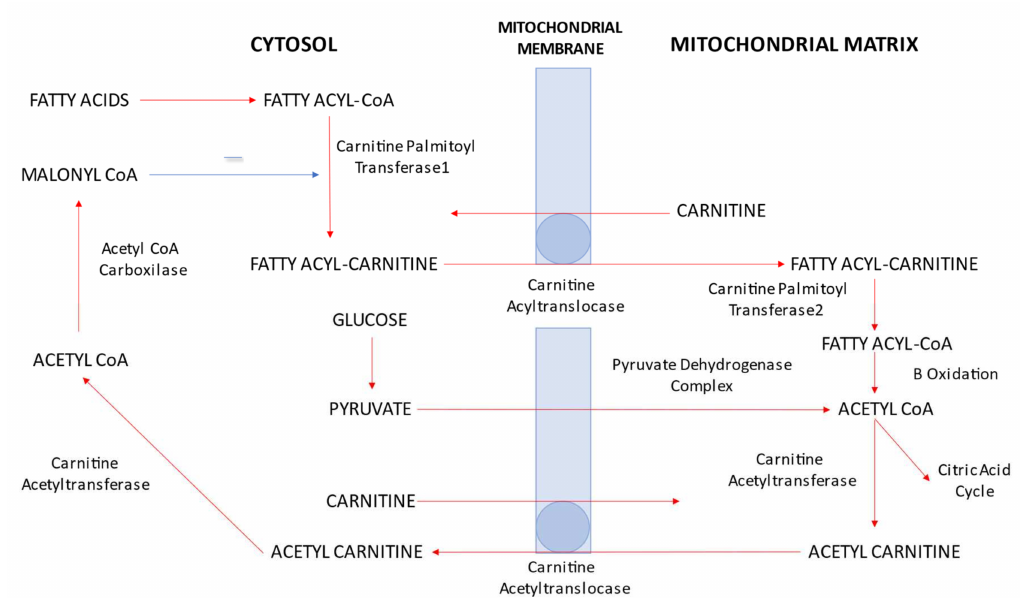
Figure 1. Role of carnitine in fatty acid uptake, β -oxidation and glucose metabolism regulation. CoA: coenzyme